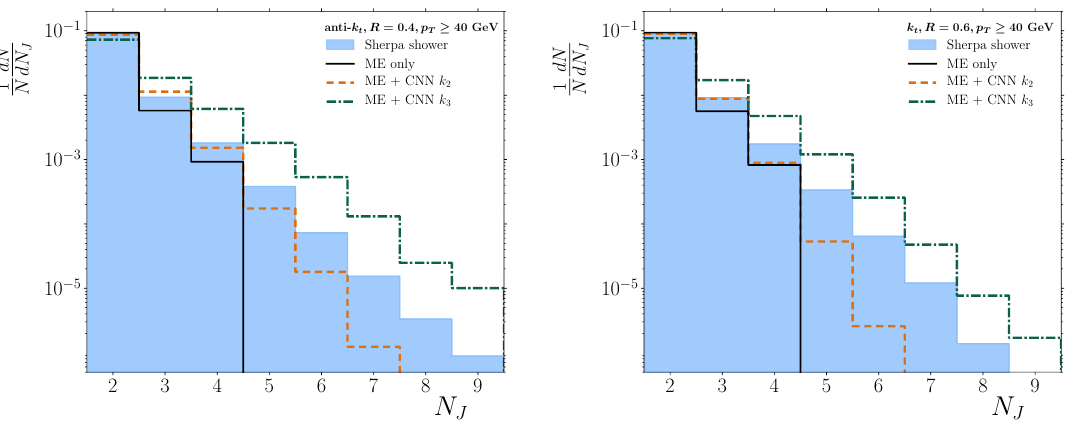
Figure 6 . Number of jets per event using the anti- k t R=0.4 jet algorithm (left) and the k t R=0.6 algorithm (right).